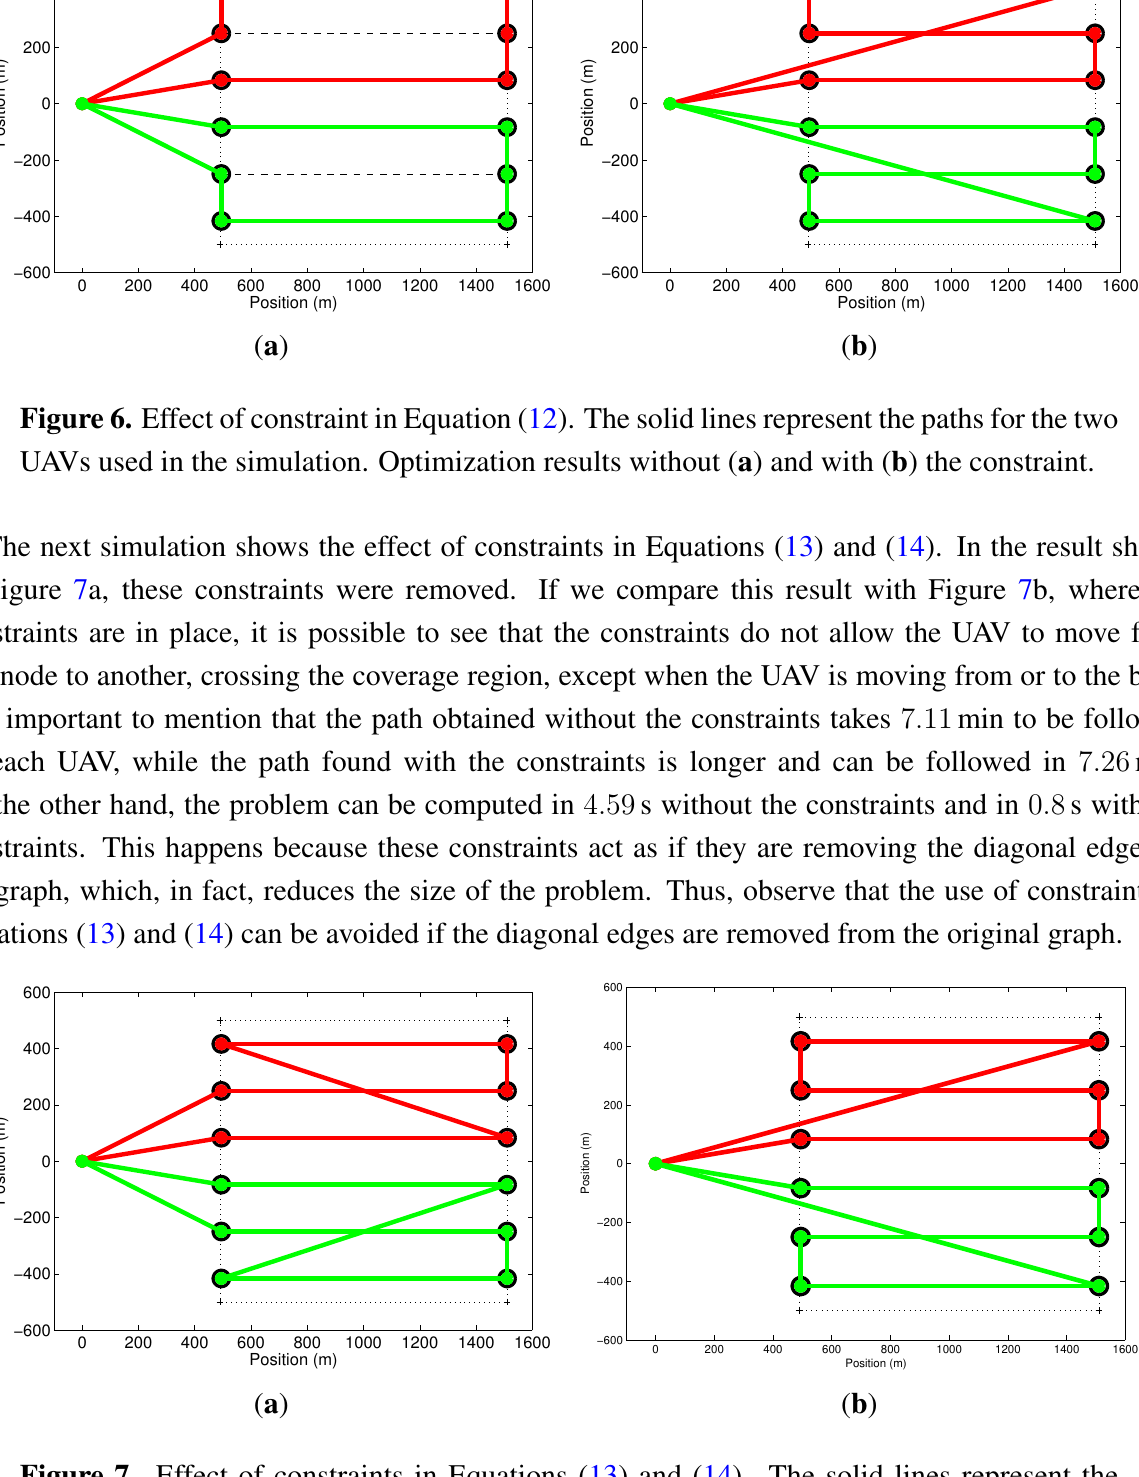
Figure 7. Effect of constraints in Equations (13) and (14). The solid lines represent the paths for the two UAVs used in the simulation. Optimization results without ( a ) and with ( b ) the